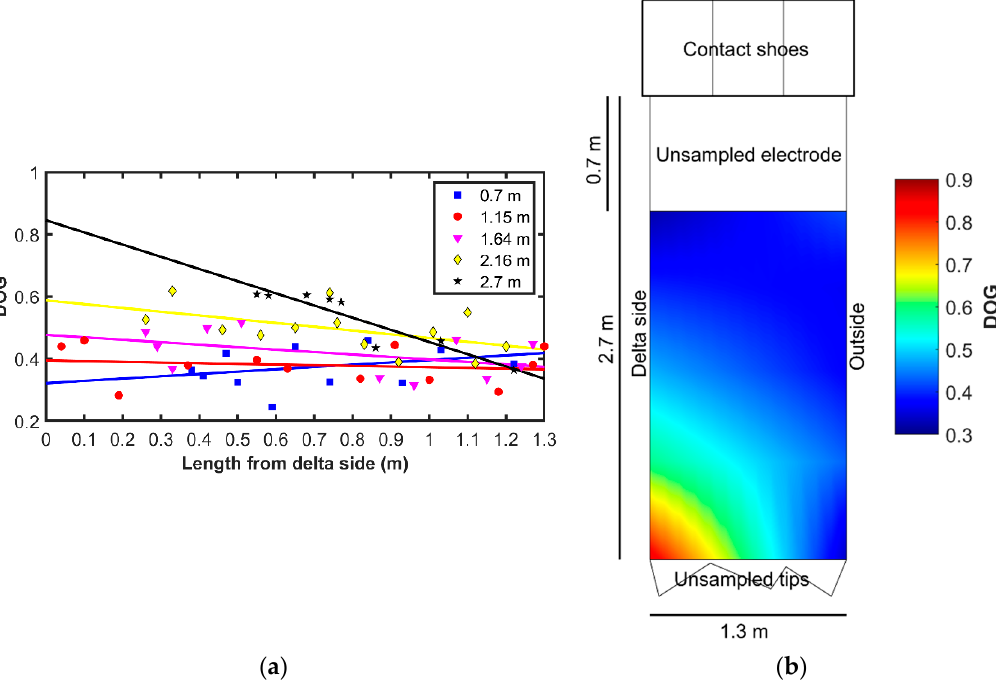
Figure 6. ( a ) Average measured degree of graphitisation (DOG) (markers) and linear fitting of this data (lines), as a function of length below the contact shoes and distance from the delta side of the electrode; ( b ) 3D rendering of the fitted line data associated with DOG at 10 mm intervals across the electrode at each of the lengths below the contacts shoes indicated in Figure 6(a).